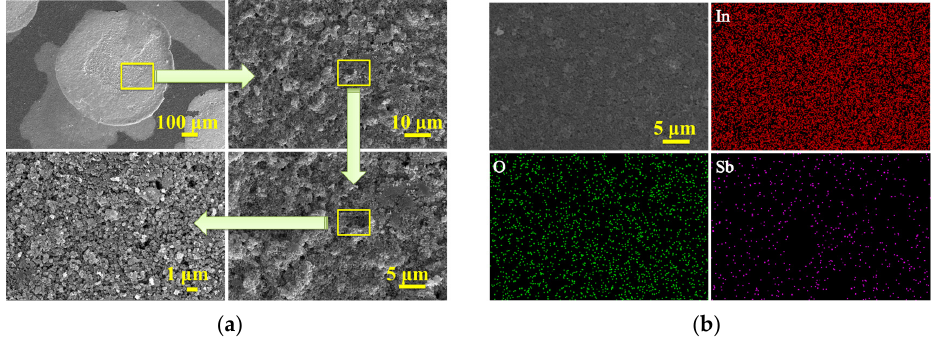
Figure 3. ( a ) Macroscopic and microscopic FESEM diagrams of Pr 0 . 5 In gas-sensitive film; ( b ) EDS diagram of Sb 0 . 5 In gas-sensitive film.